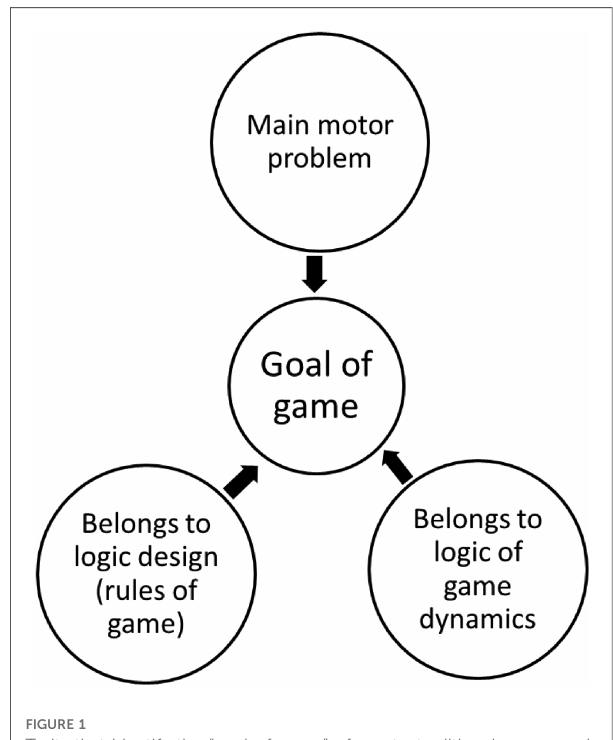
FIGURE 1 Traits that identify the “ goal of game ” of sports, traditional games and modi fi ed